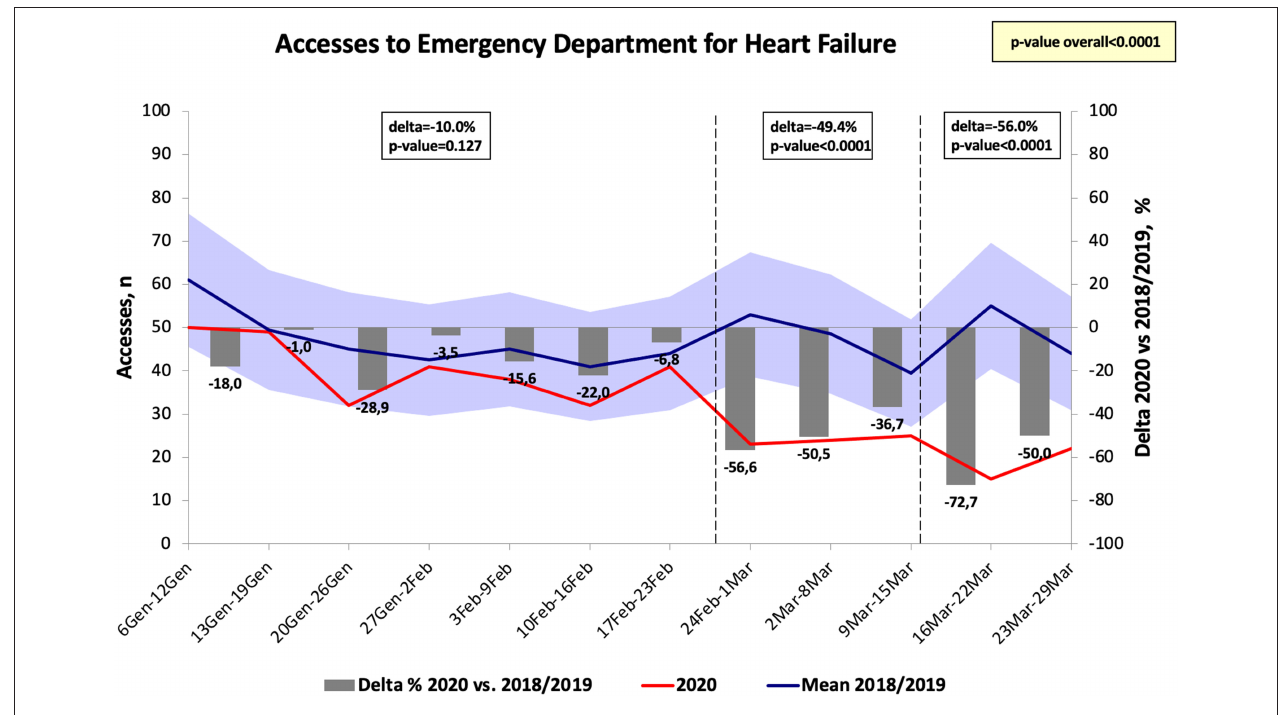
FIGURE 4 | Number of accesses to emergency department for acute coronary syndrome in Tuscany.